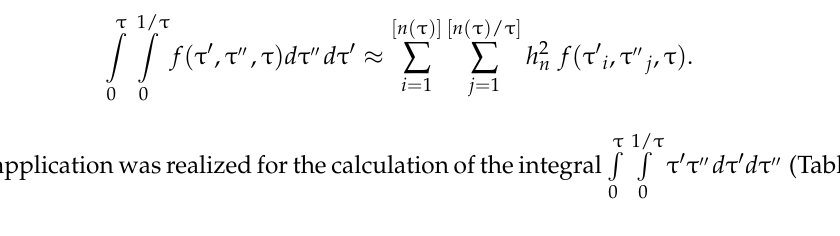
Table 17. Calculation of integral  